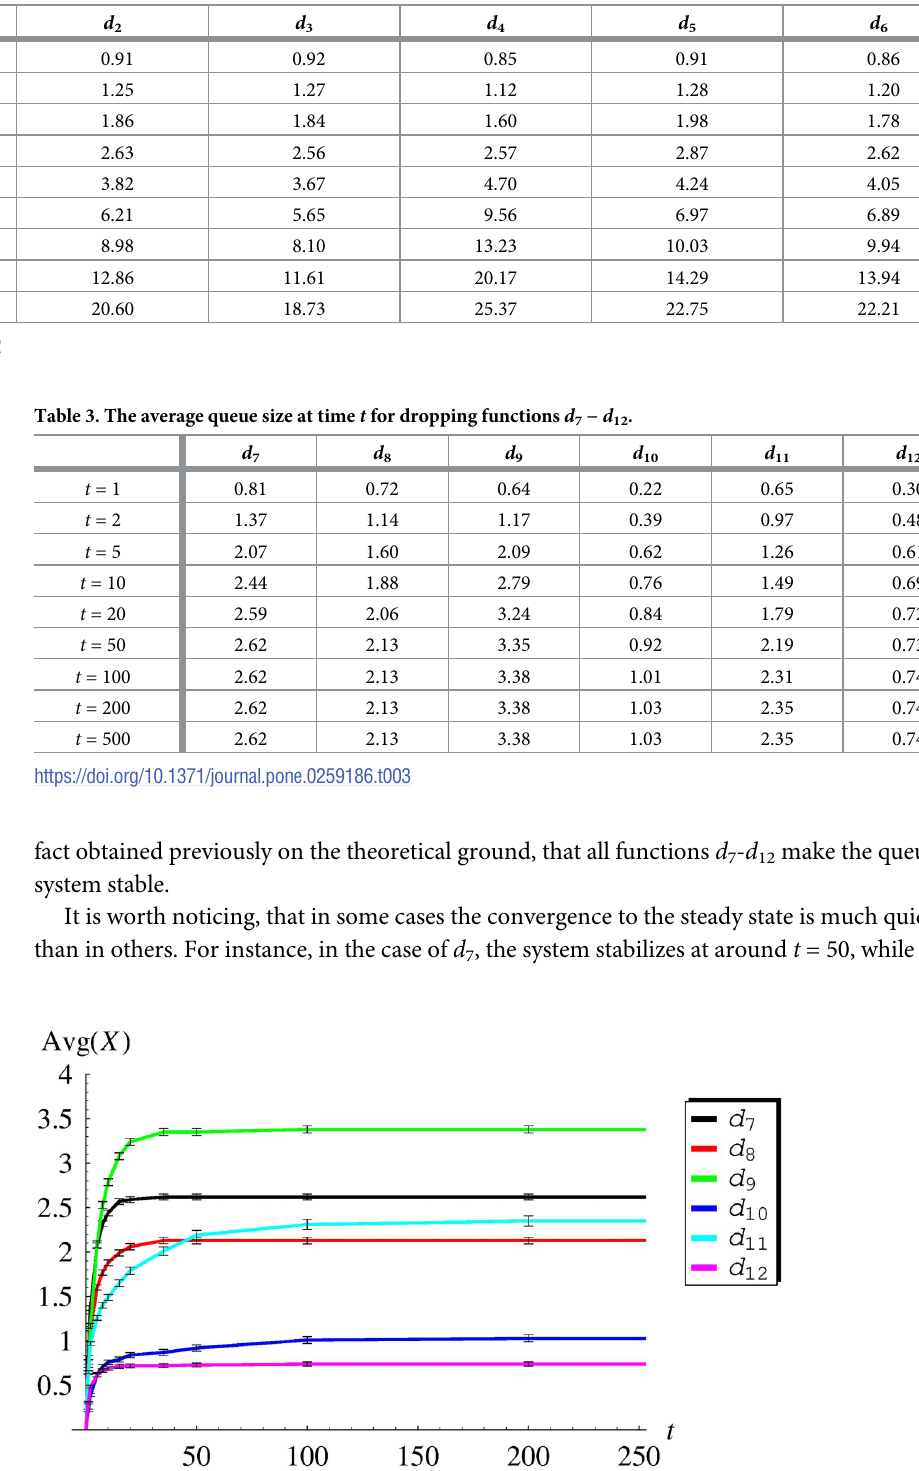
Table 2. The standard deviation of the queue size at time t for dropping functions d 1 − d 6 .